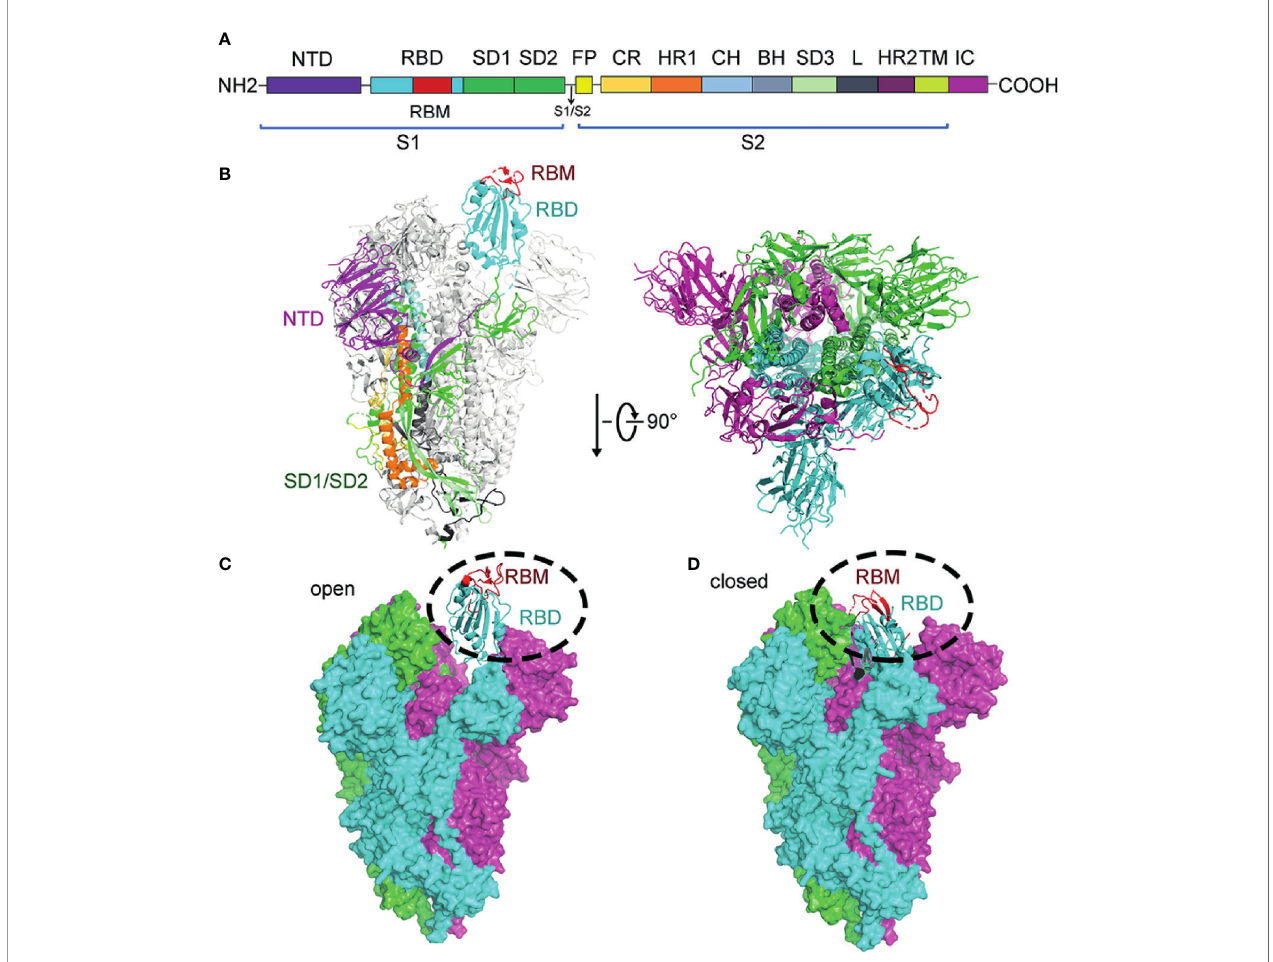
FIGURE 6 | Structure of SARS-CoV-2 spike protein. (A) Schematic of the SARS-CoV-2 spike protein primary structure colored by domain. NTD, N-terminal domain; RBD, receptor binding domain; RBM, receptor binding motif; SD1, subdomain 1; SD2, subdomain 2; FP, fusion peptide; CR, connecting region; HR1, heptad repeat 1; CH, central helix; BH, b -hairpin; SD3, subdomain 3; HR2, heptad repeat 2; TM, transmembrane domain; IC, cytoplasmic tail. Arrows denote protease cleavage sites. (B) From the side view and top view, the Cryo-EM structure of the SARS-CoV-2 spike in the prefusion conformation shows that a single RBD is in the up conformation and other RBDs are in the down conformation in either white or gray. The RBD, which in up conformation, is shown in ribbons colored corresponding to the schematic in (A) . (C) Cryo-EM structure of the SARS-CoV-2 spike in the open state. There is one open RBD domain. The three chains are depicted in green, cyan, and magnet, respectively. RBD and RBM are shown in cyan and red cartoon, respectively. (D) Cryo-EM structure of the SARS-CoV-2 Spike in the closed state. The three chains are depicted in green, cyan, and magnet, respectively. RBM is colored in red. RBD and RBM are shown in cyan and red cartoon, respectively. All structures are drawn by